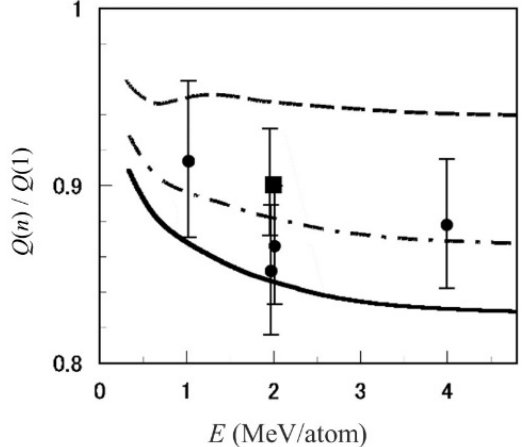
mental data. It is remarkable that the energy loss per atom difference at lower (less than